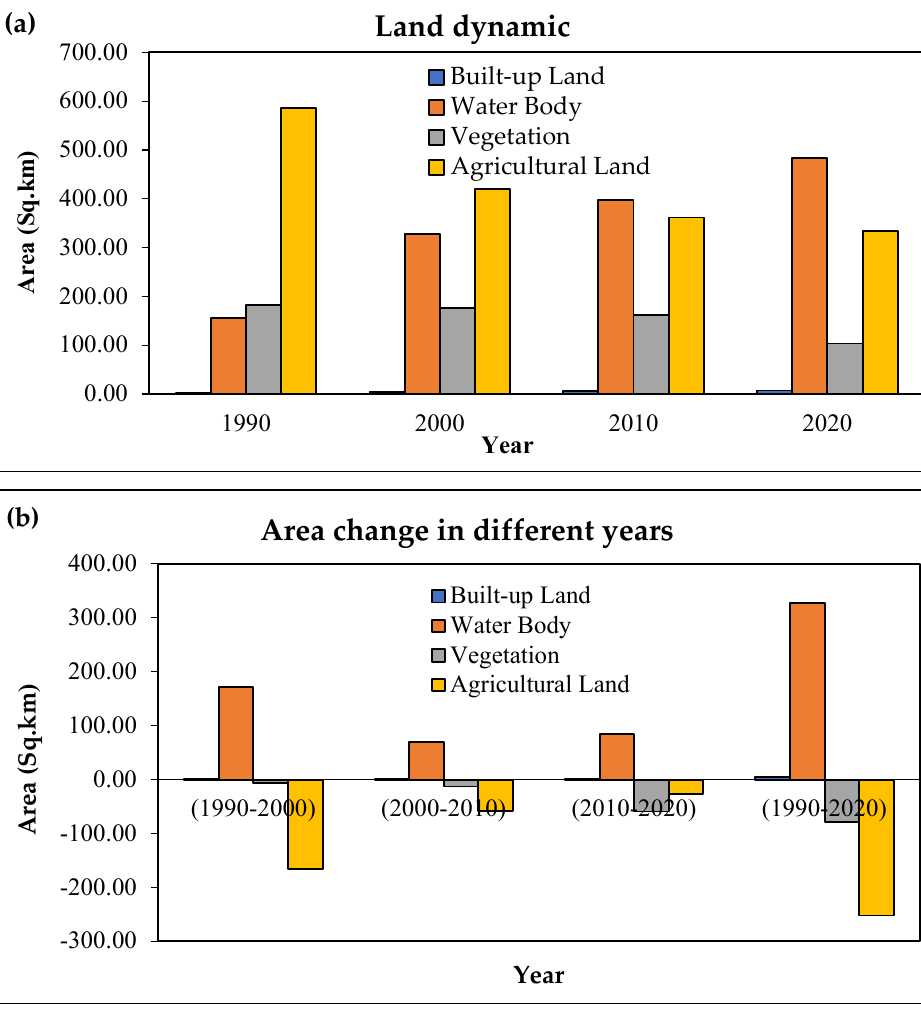
Figure 4. LU/LC classification area calculation; ( a ) total LU/LC classes in different time periods; ( b ) loss/gain analysis of different years.